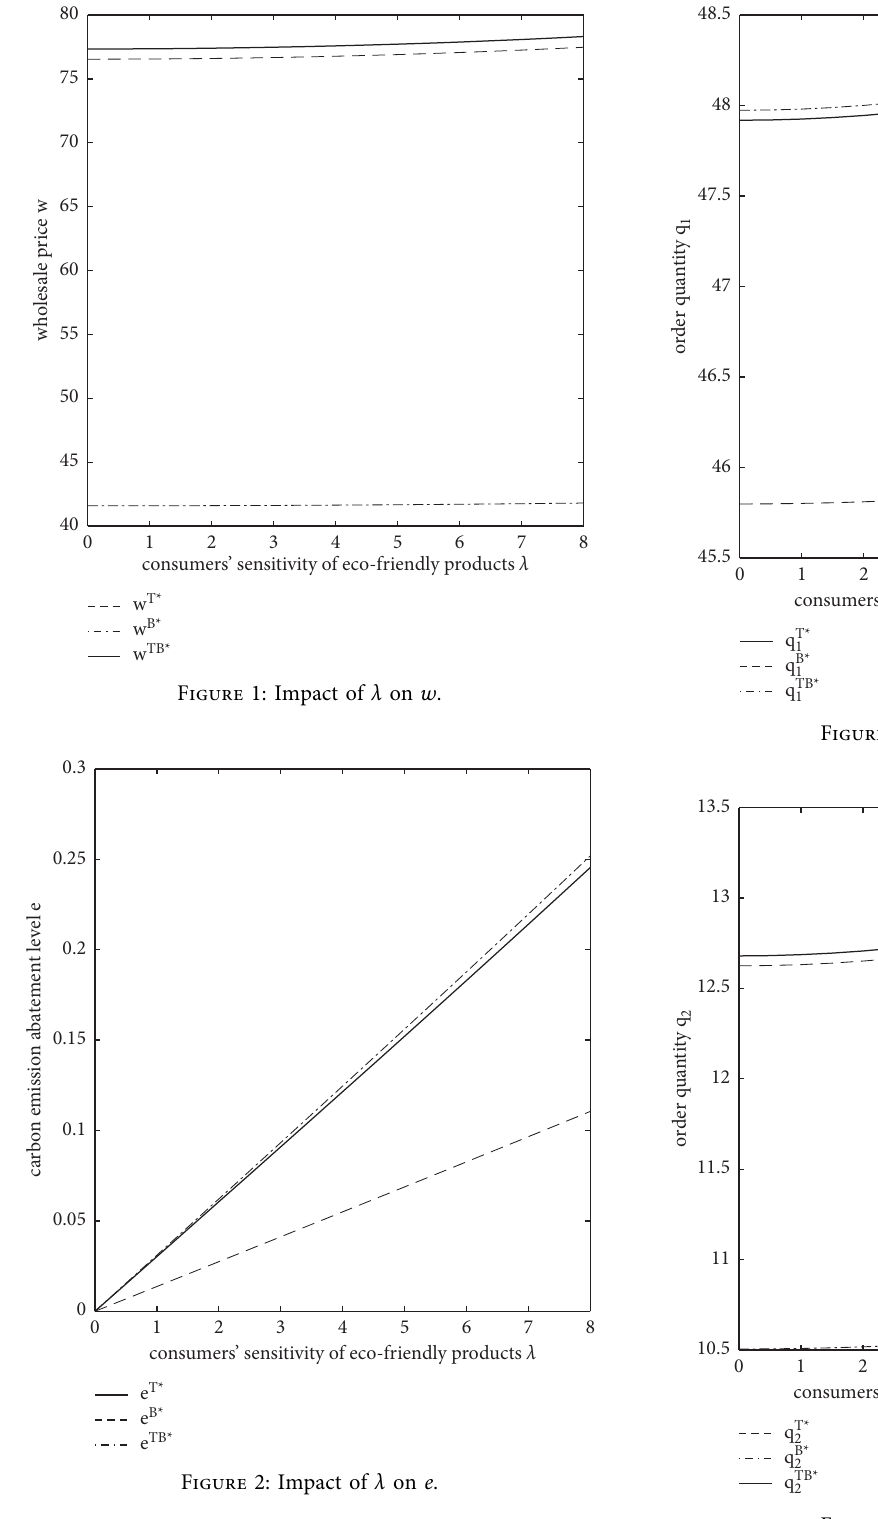
Figure 4: Impact of λ on q